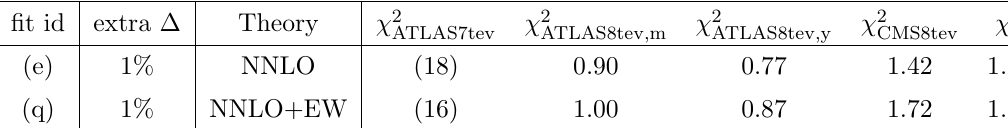
Table 9 . Fully correlated (cid:31) 2 for the experiments in the HERA + p Z